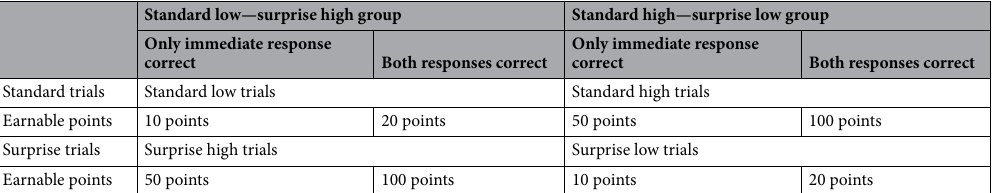
Table 1. Reward conditions in standard and surprise trials for both reward manipulation